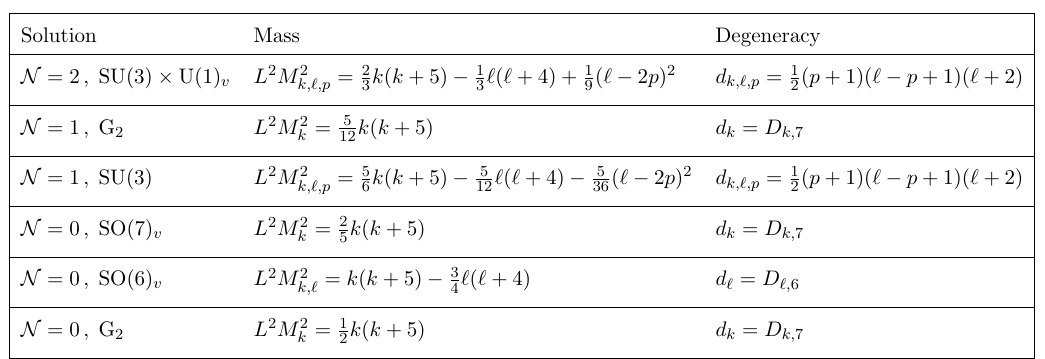
Table 3 . The KK graviton spectra of AdS 4 solutions of massive IIA supergravity that uplift from critical points of D = 4 N = 8 dyonic ISO(7)-gauged supergravity with at least SU(3)